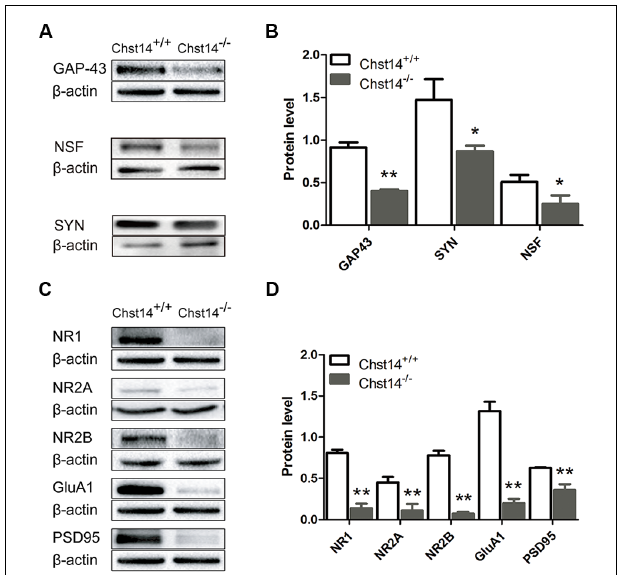
FIGURE 3 | Chst14/D4st1 deficiency decreases protein expression of the synaptic proteins in the hippocampus. Total proteins from WT or Chst14 − / − mice hippocampi were subjected to Western blot analysis to determine the protein levels of the synaptic proteins. (A,B) Representative immunoblots and densitometric analysis of the immunoblots showed that the expression levels of growth associated protein 43 (GAP-43), N-ethylmaleimide sensitive factor (NSF) and synaptophysin (SYN) in the hippocampi were significantly decreased in the Chst14 − / − mice. (C,D) Representative immunoblots and densitometric analysis of the immunoblots showed that the expression levels of NR1, NR2A, NR2B, GluA1 and postsynaptic density 95 (PSD95) were significantly decreased in the Chst14 − / − mice. Here, NR1, GluA1 and β -actin immunoblots were performed on the different parts of PVDF membrane from the same gel, thus NR1 and GluA1 were normalized to the same β -actin bands. Graphs represent the means ± SEM ( n = 4 mice for each group). GAP-43, PSD95 and β -actin immunoblots were performed on the different parts of PVDF membrane from the same gel, thus GAP-43 and PSD95 were normalized to the same β -actin bands. Graphs represent the means ± SEM ( n = 4 mice for each group). ∗ p < 0.05, ∗∗ p < 0.01.